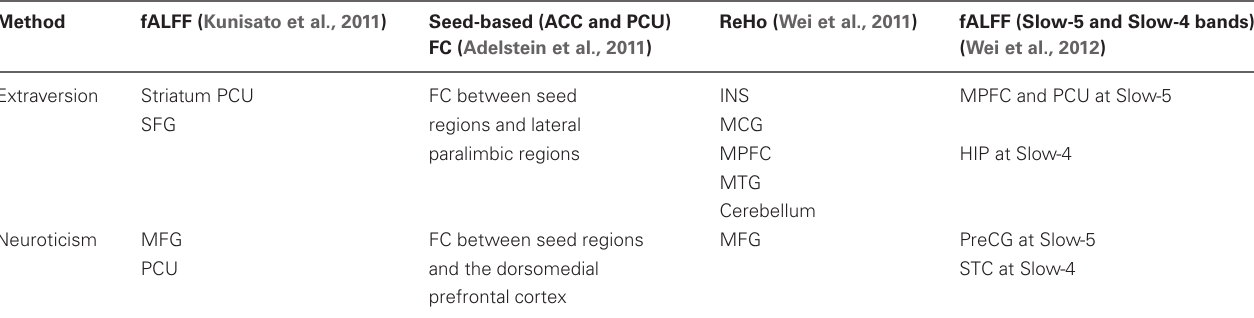
Table 1 | The main results on the characteristics of resting brain functions associated with extraversion and neuroticism in recent resting-state fMRI